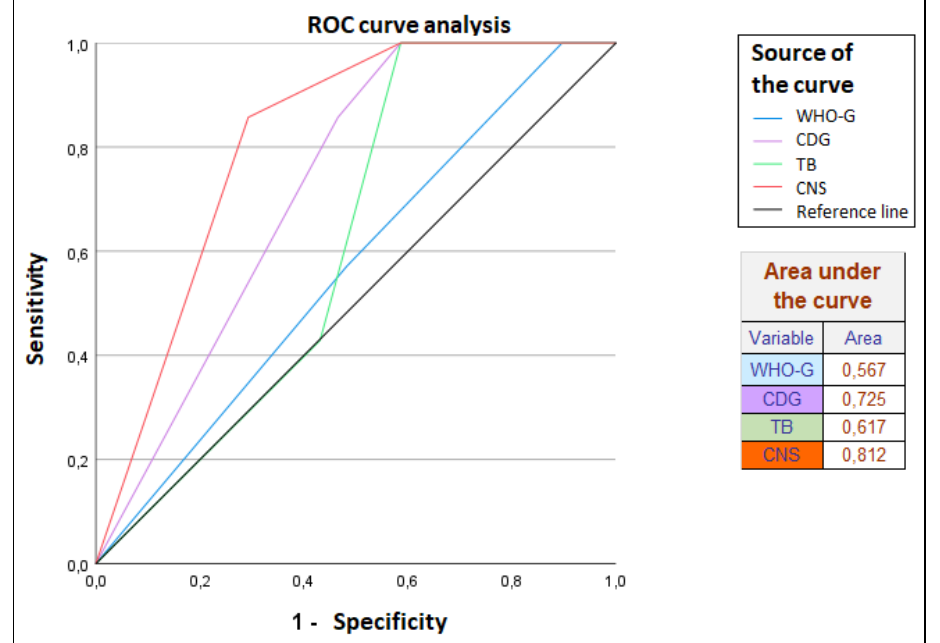
Figure 10. ROC curve regarding prognosis for pN. Table 3. Interobserver concordance for CDG evaluation.